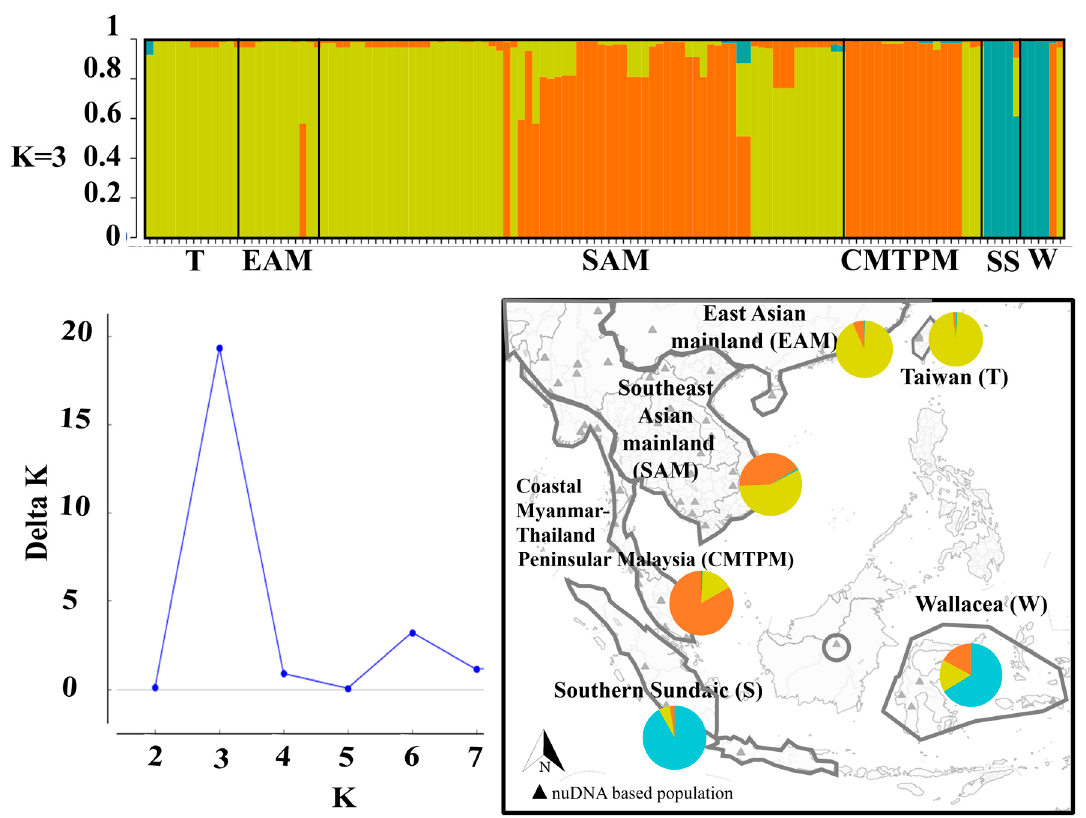
Figure 6. ADMIXTURE plot showing clustering by population for Duttaphrynus melanostictus inferred from SNP alleles from nuDNA Sox9 . The number of independent populations is inferred through the calculation of ∆ K [85]. On the bar plot, each column represents a single individual, and framed areas isolate each population such as defined on the map.